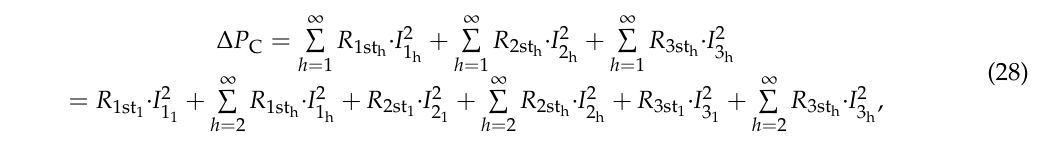
( b ) Figure 16. The dependence of increasing APLs from three-phase active power consumption for ACSR 70/11: ( a ) the length of 5 km; ( b ) the length of 30 km.